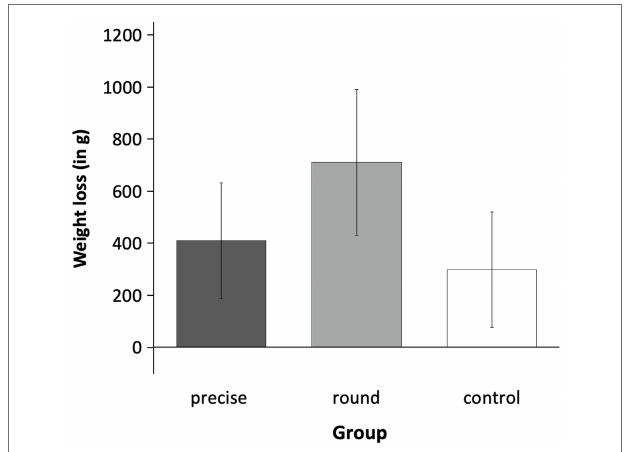
FIGURE 2 | Weight loss in Experiment 2. The three experimental conditions (precise goal vs. round goal vs. control) did not differ significantly in weight loss. Error bars represent